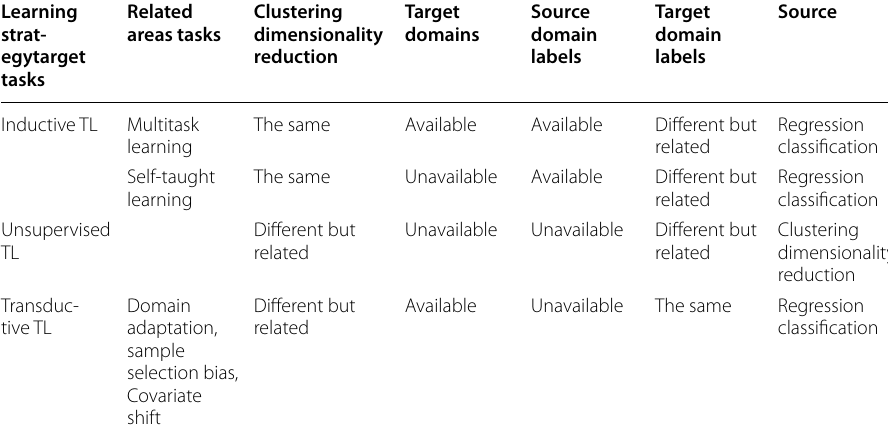
Table 1 TL strategies and its settings Learning strat- egytarget